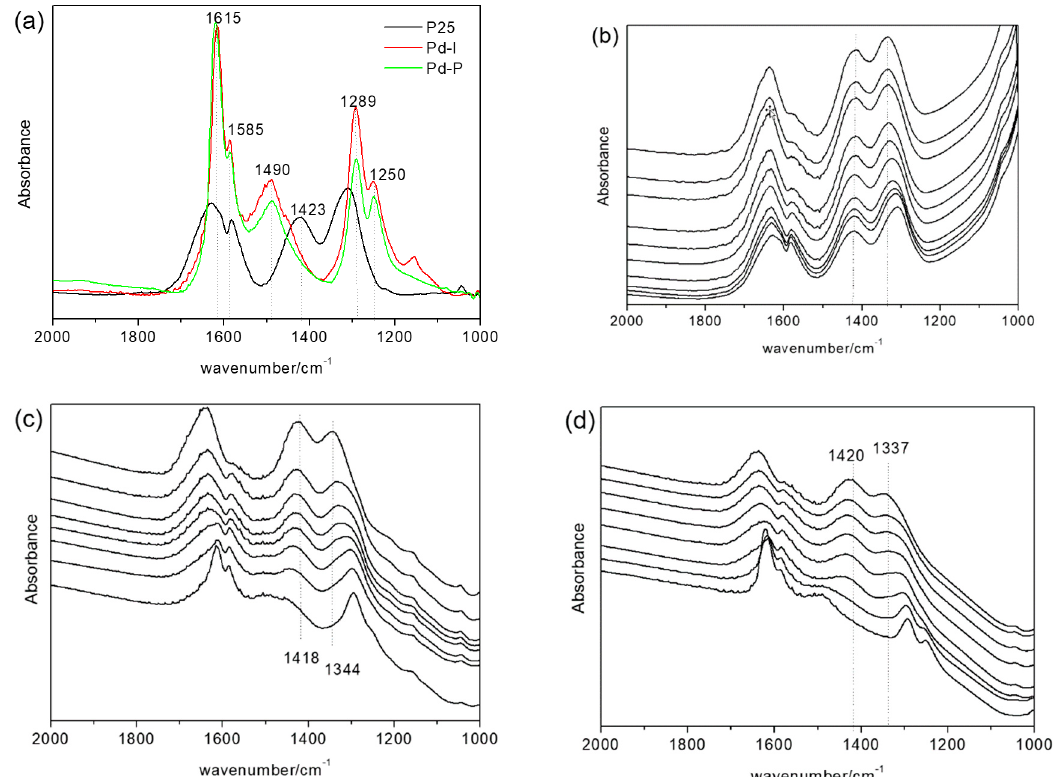
Figure 8. Initial FTIR spectra ( a ) and spectra obtained after 24 h of reaction at 0% RH of the P25 ( b ), Pd-P ( c ) and Pd-I ( d ).